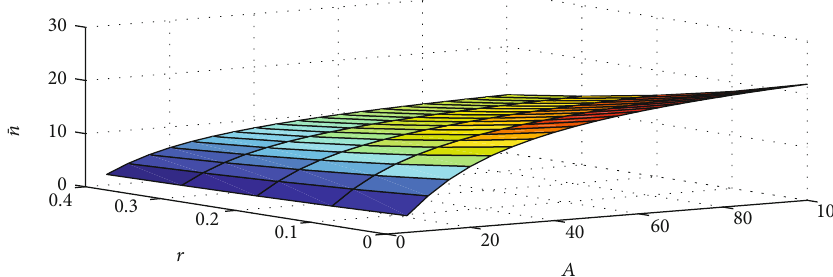
Figure 5: Plots of the mean photon number (Equation (28)) versus r and A for η = 0 : 1 and κ = 0 : 8